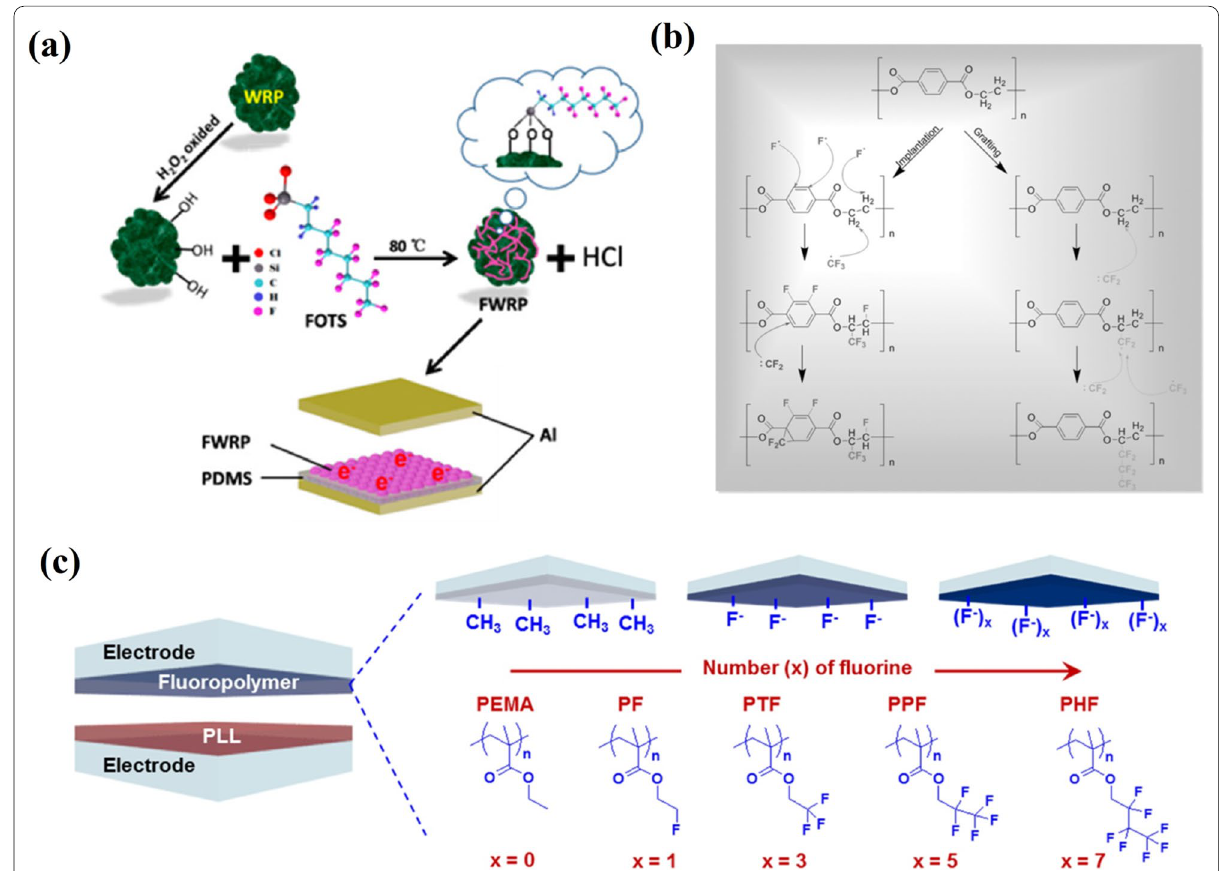
Fig. 11 Chemical functionalization of TENG surface layer: a schematic representation of surface fluorinated modification of WRP by FOTS (Reproduced with permission from Ref. [78]); b schematics illustrations of the reactions of fluorination on a PET surface (Reproduced with permission from Ref. [79]); c a schematic of TENG based on the fluorinated polymers with different kinds of fluorine units (Reproduced with permission from Ref.